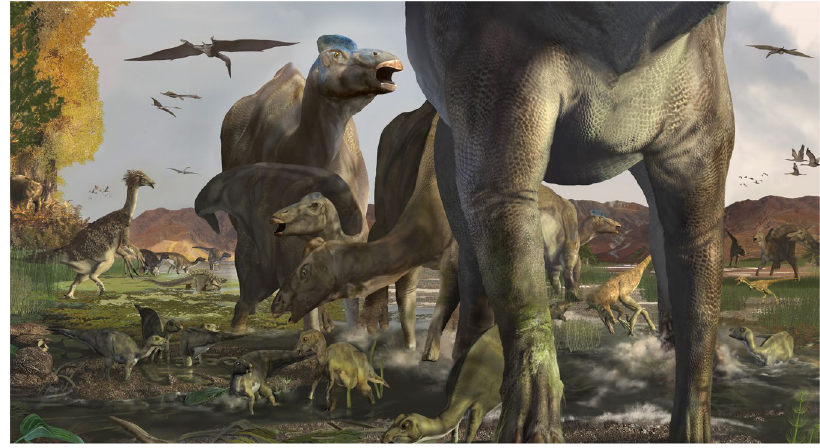
Figure 11. Life reconstruction of hadrosaur-therizinosaur co-occurrence based on tracks described in this report. Artwork by Karen